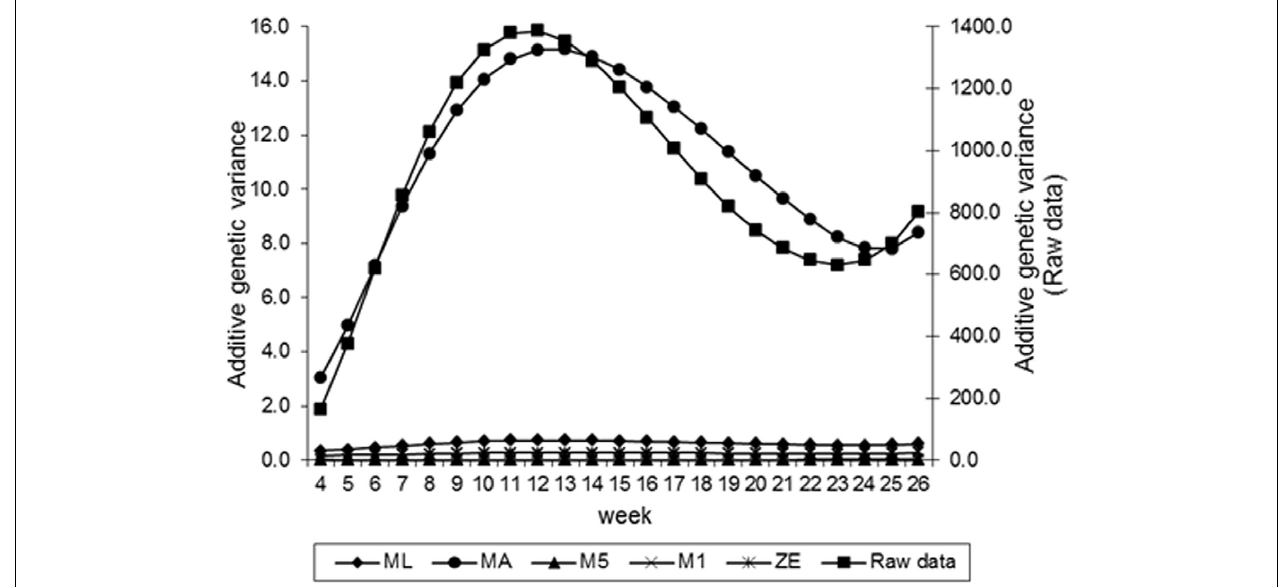
FIGURE 2 | Estimates of additive genetic variance of fecal egg count (FEC) over time for different values of λ .